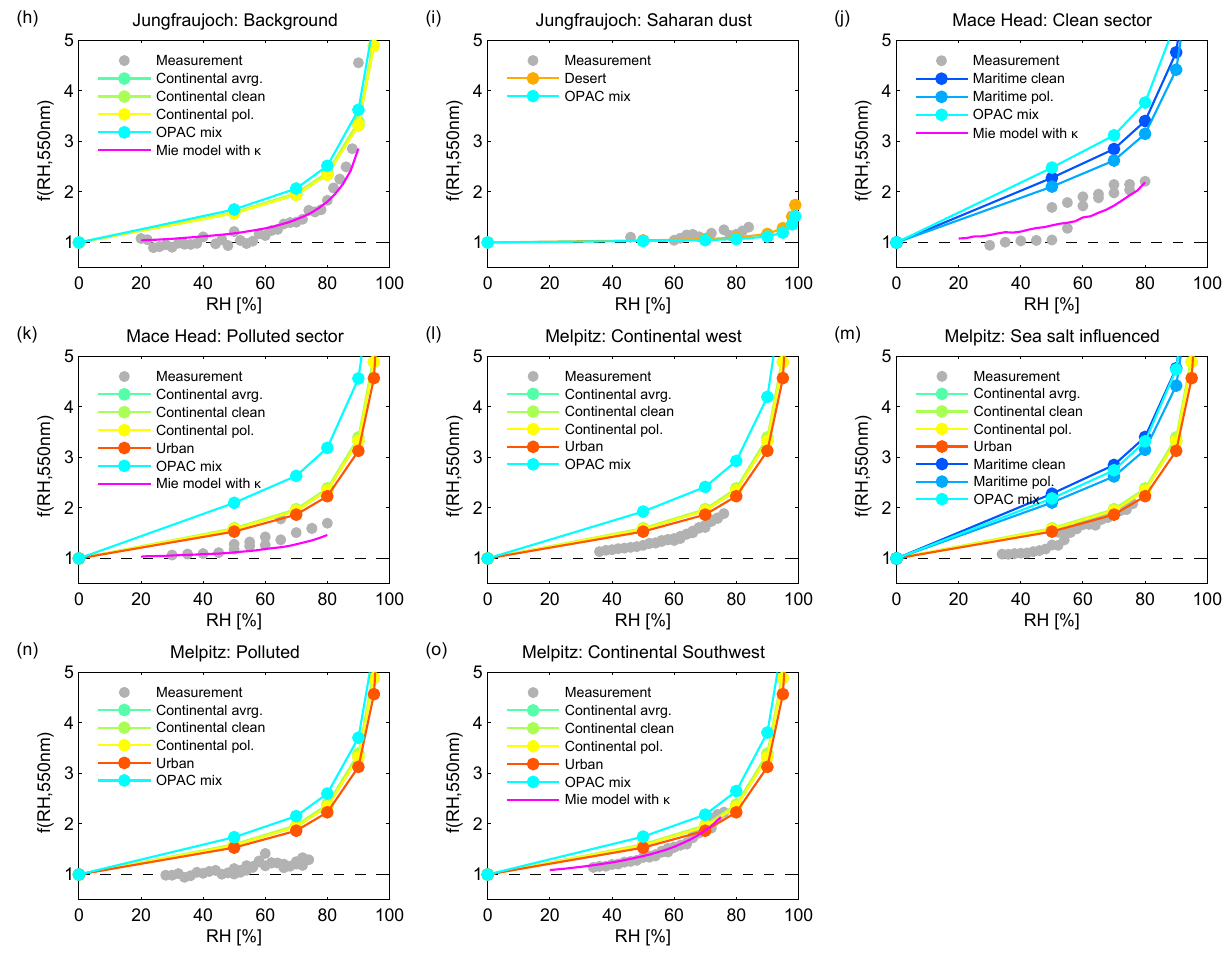
Fig. 9. Same as Fig. 8, but for the other